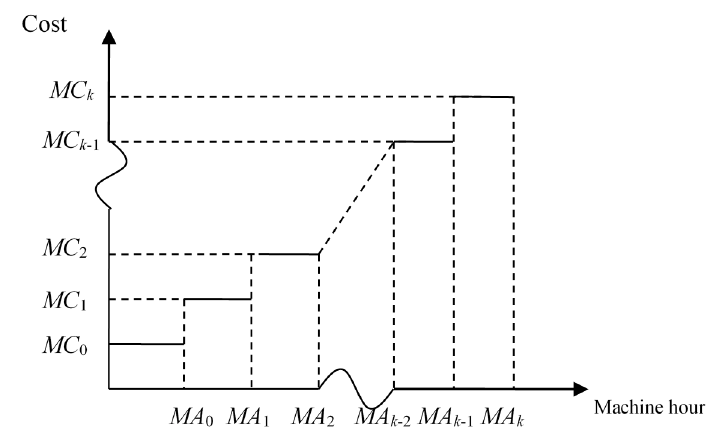
Figure 9. Stepwise process-level activity cost.